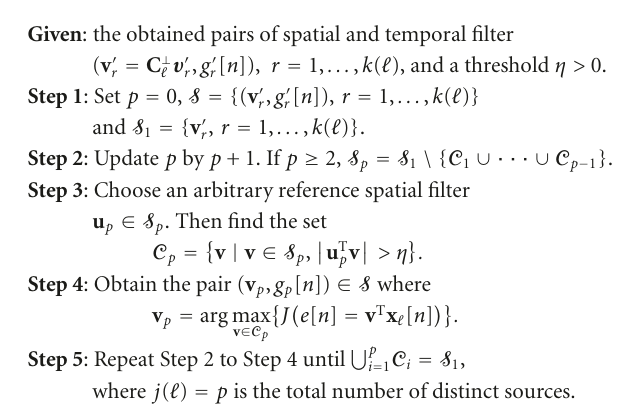
Given : the obtained pairs of spatial and temporal filter